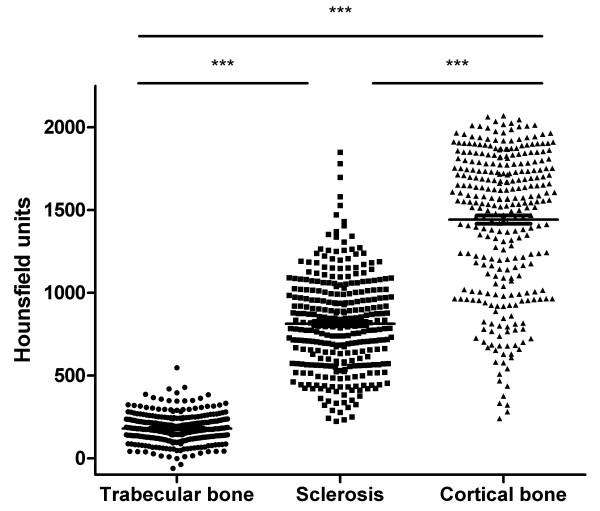
Hounsfield units at sites of sclerosis and adjacent bone in joints affected by bone sclerosis. ***P < 0.0001 by Tukey's post hoc test.